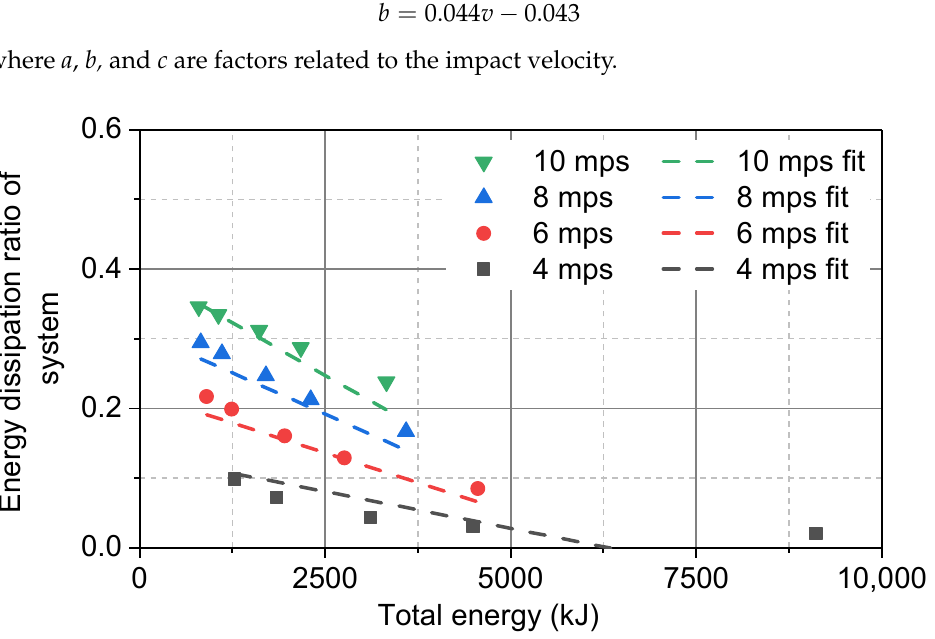
Figure 13. Energy dissipation ratio of the flexible barrier.